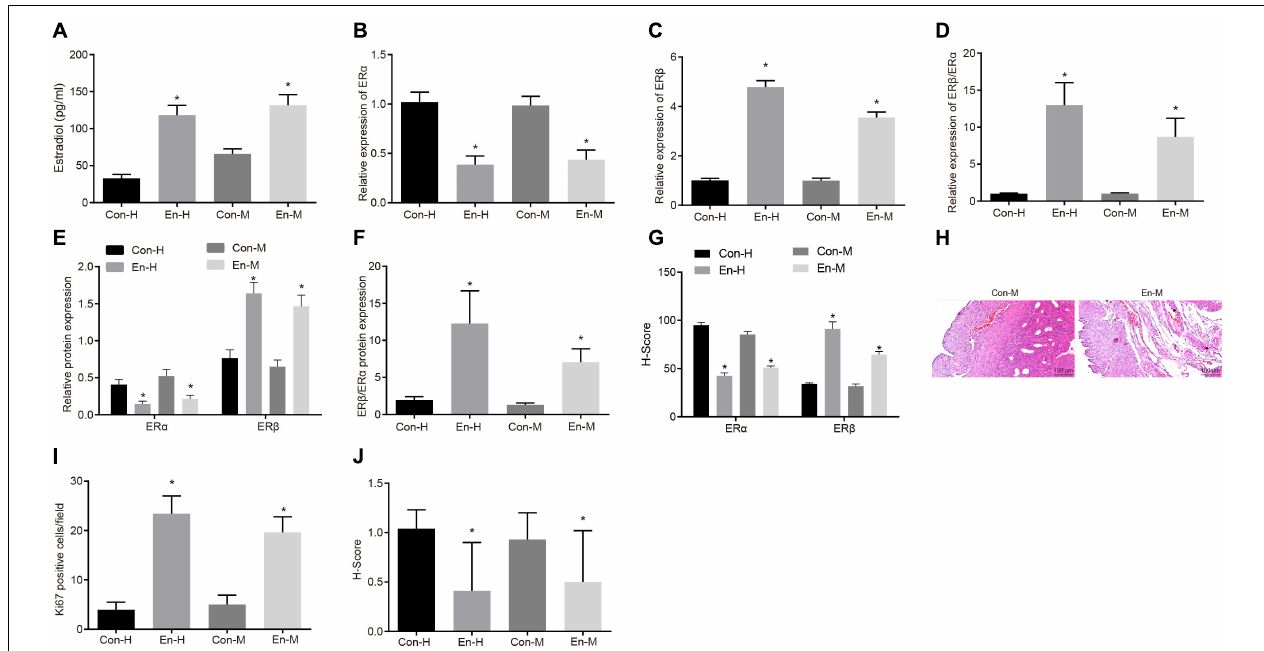
FIGURE 1 | Content of estradiol and expression levels of ER β and ER α in human and mouse endometriosis. (A) The expression of estradiol in human and mouse endometriosis/normal tissues determined by ELISA. (B) The mRNA expression of ER α in human and mouse endometriosis/normal tissues determined by RT-qPCR. (C) The mRNA expression of ER β in human and mouse endometriosis/normal tissues determined by RT-qPCR. (D) The relative expression of ER β /ER α in human and mouse endometriosis/normal tissues determined by RT-qPCR. (E) The protein expression of ER α and ER β in human and mouse endometriosis/normal tissues determined by Western blot analysis. (F) The protein expression of ER β /ER α in human and mouse endometriosis/normal tissues determined by Western blot analysis. (G) , The statistical analysis of immunohistochemical staining of ER α and ER β in human and mouse endometriosis/normal tissues. (H) HE staining of mouse endometriosis and normal tissues. (I) , The statistical analysis of fluorescence staining of Ki67 in human and mouse endometriosis/normal tissues. (J) The statistical analysis of immunohistochemical staining of cleaved caspase-8 in human and mouse endometriosis/normal tissues. Comparisons between two groups were analyzed using independent sample t -test. * p < 0.05 vs. the human or mouse normal tissues. n = 78 for human normal tissues; n = 91 for human endometriosis tissues; n = 14 for mouse endometriosis/normal